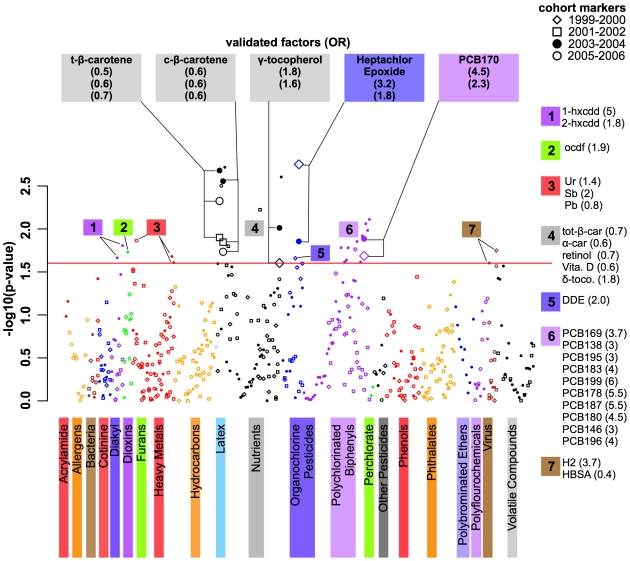
“Manhattan plot” style graphic showing the environment-wide association with T2D.Y-axis indicates −log10(p-value) of the adjusted logistic regression coefficient for each of the environmental factors. Colors represent different environmental classes as represented in Figure 1A. Within each environmental class, factors are arranged left to right in order from lowest to highest odds ratio (OR). Plot symbols represent different cohorts: 1999–2000 (diamonds), 2001–2002 (square), filled dot (2003–2004), circle (2005–2006). Red horizontal line is −log10(α) = 1.8 (α = 0.02). Validated factors significant in 2 or more NHANES cohorts are in bold face (α = 0.02 in two or more cohorts, FDR of 2%) with larger plot points. Other significant factors (α = 0.02) are annotated with numeric label corresponding to the environmental factor class color key on the right. Figure abbreviations: Validated factors: t-β-carotene: trans β-carotene; c-β-carotene: cis β-carotene; PCB170: 2,2′,3,3′,4,4′,5-Heptachlorobiphenyl. Group 1 (dioxins): 1-hxcdd: 1,2,3,6,7,8-Hexachlorodibenzo-p-dioxin; 2-hxcdd: 1,2,3,7,8,9-Hexachlorodibenzo-p-dioxin. Group 2 (furans): OCDF: 1,2,3,4,6,7,8,9-Octachlorodibenzofuran. Group 3 (heavy metals): Ur: uranium; Sb: antimony; Pb: Lead. Group 4 (nutrients): tot-β-car: total β-carotene; α-car: alpha-carotene; retnl: retinol; Vita. D: vitamin D; δ-t: delta-tocopherol. Group 5 (organochlorine pestcides): DDE: dichlorodiphenyltrichloroethylene. Group 6 (PCB): PCB169: 3,3′,4,4′,5,5′-hexachlorobiphenyl; PCB138: 2,2′,3,4,4′,4′,5-Hexachlorobiphenyl; PCB195: 2,2′,3,3′,4,4′,5,6-Octachlorobiphenyl; PCB183: 2,2′,3,4,4′,5′,6-Heptachlorobiphenyl; PCB199: 2,2′,3,3′,4,5,5′,6′-Octachlorobiphenyl; PCB178: 2,2′,3,3′,5,5′,6-Heptachlorobiphenyl; PCB187: 2,2′,3,4′,5,5′,6-Heptachlorobiphenyl; PCB180: 2,2′,3,4,4′,5,5′-Heptachlorobiphenyl; PCB146: 2,2′,3,4′,5,5′-Hexachlorobiphenyl; PCB196: 2,2′,3,4,4′,5,5′,6-Octachlorobiphenyl. Group 7 (bacteria): H2: Herpes Simplex 2; HSBA: Hepatitis B Surface Antibody.